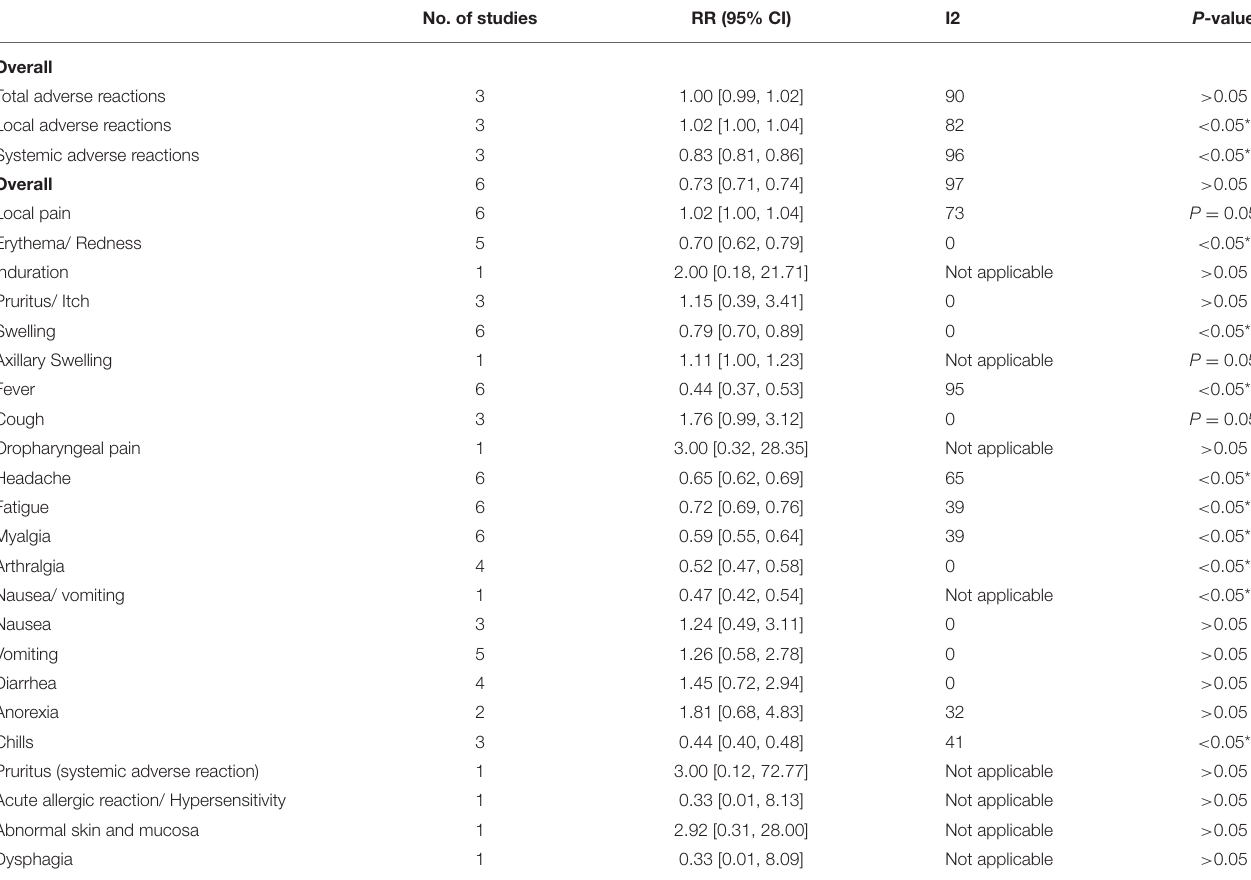
TABLE 4 | Total and specific reactions in vaccination group after dose 1 vs. after dose 2. No. of studies RR (95% CI) I2 P